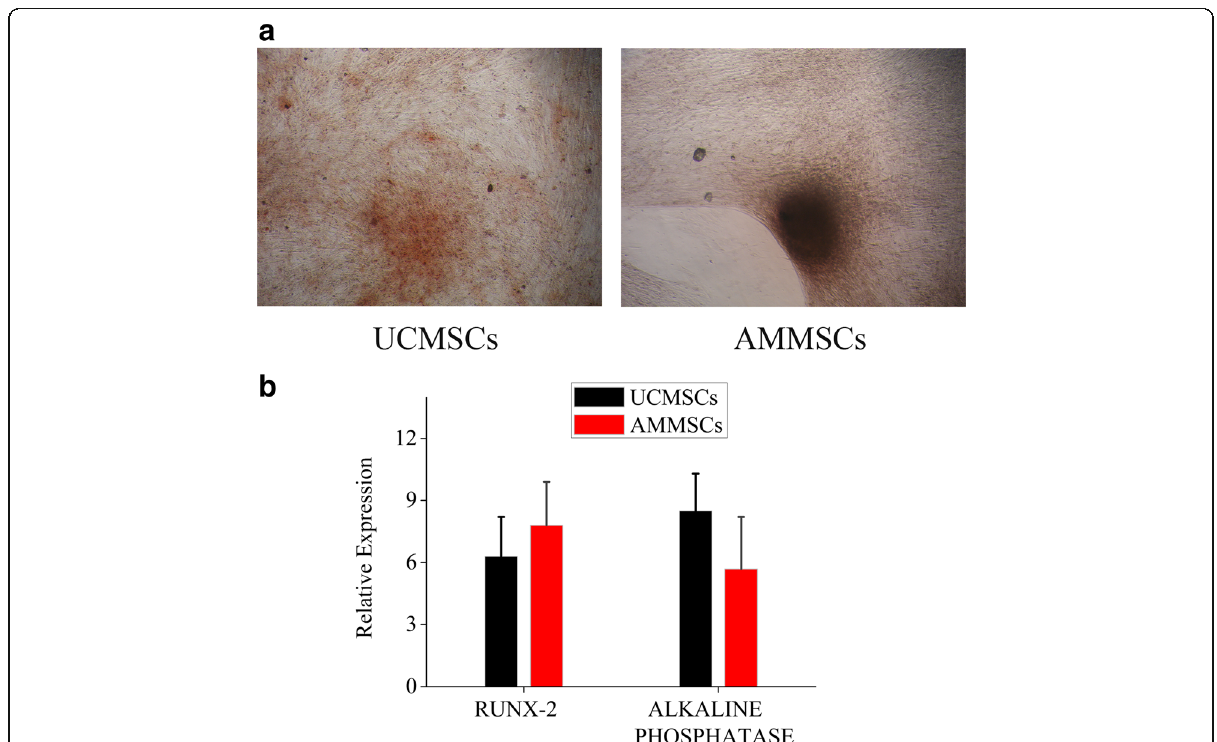
Fig. 3 AMMSCs in PL showed similar osteogenic differentiation potential with UCMSCs. a The osteogenic differentiation of AMMSCs and UCMSCs was confirmed by Alizarin Red staining of mineralization. Magnification × 100. b Comparative investigation of osteogenic differentiation capability of UCMSCs and AMMSCs was assessed by quantitative analysis of RUNX-2 and alkaline phosphatase mRNA expression. Bars